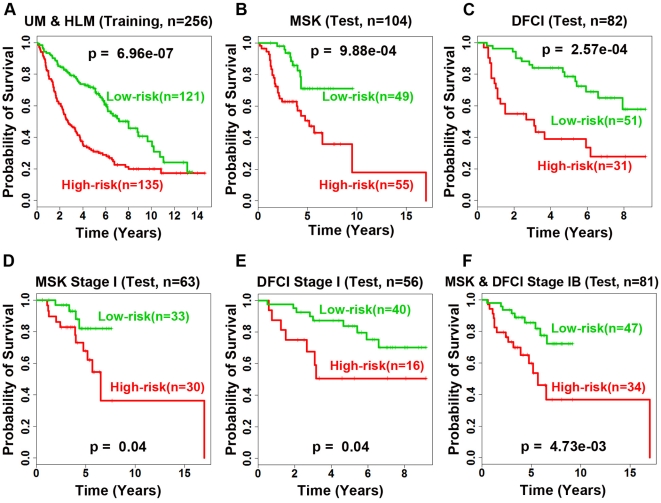
Kaplan-Meier analyses of the 12-gene prognostic model in patients with resectable lung adenocarcinoma.The model stratified patients into two significantly distinct (log-rank P<6.96e-7) prognostic groups in the training set (A) in 10-fold cross validation. The training model was applied to two test sets (B and C) and generated significant patient stratification. This model separated (log-rank P<0.04) stage I patients in both test sets (D and E) as well as stage IB patients (log-rank P<4.73e-3) from test sets (F).